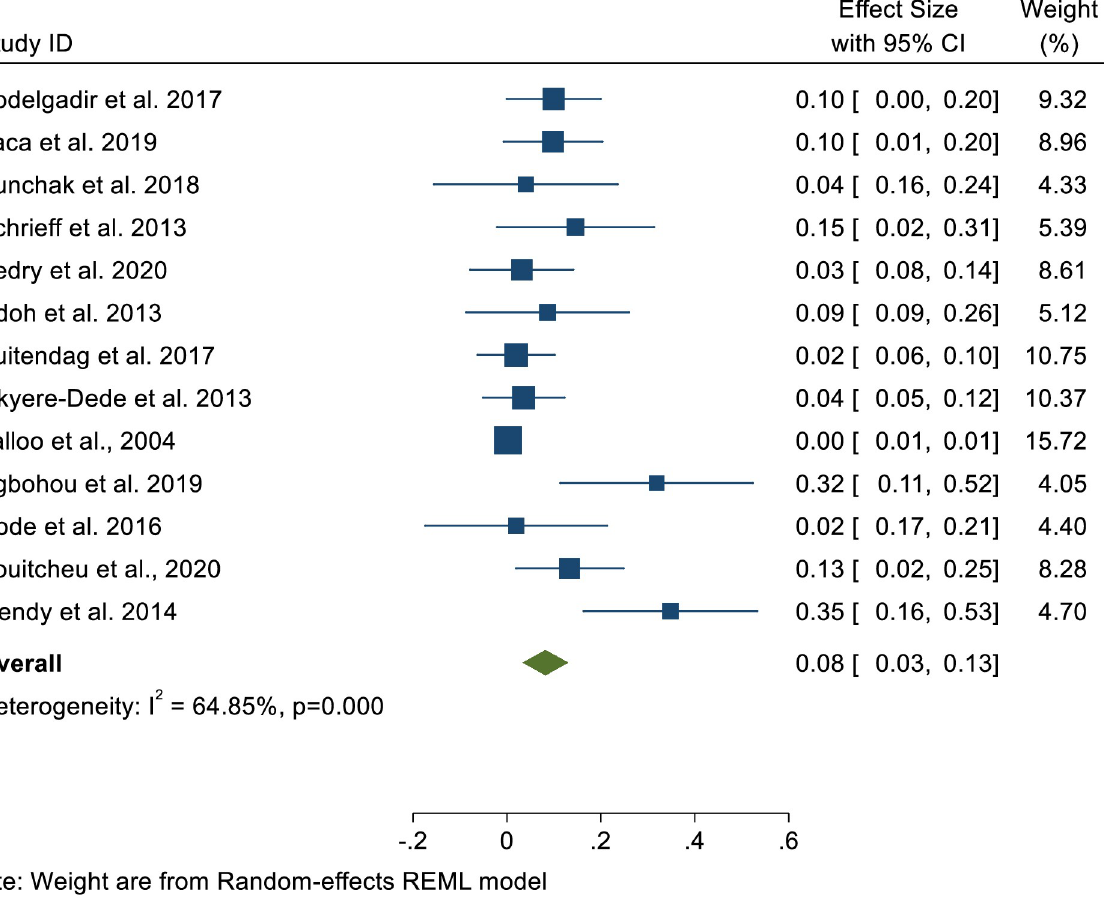
Fig 2. Forest plot of pooled case fatality rate of children’s TBI in Sub-Saharan Africa.